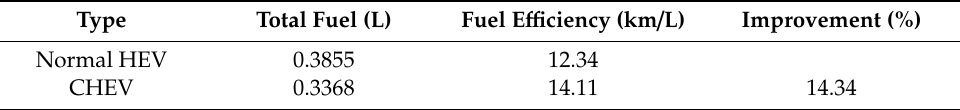
Figure 12. Cumulative fuel consumption. Table 2. Fuel efficiency comparison of normal HEV and CHEV.